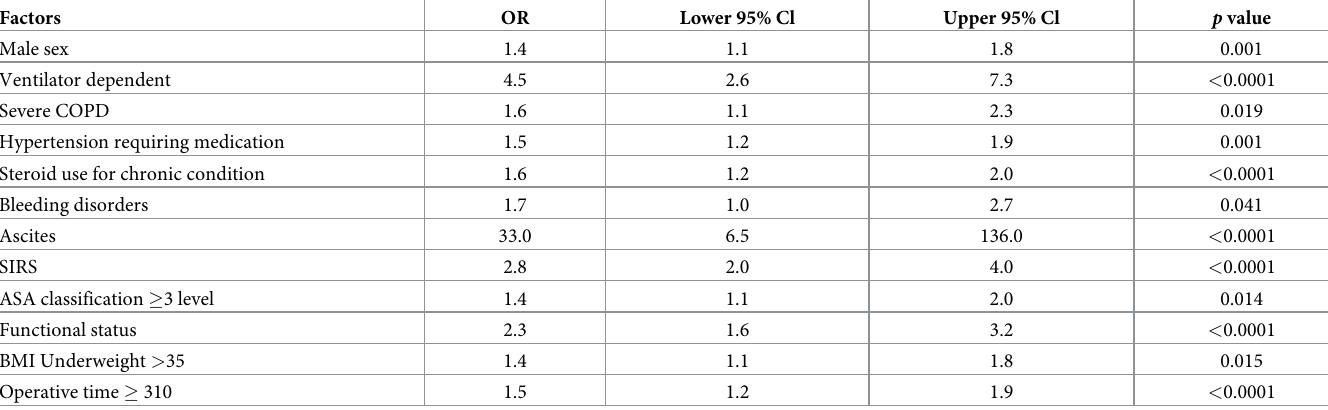
Table 6. Preoperative/Intraoperative factors associated with